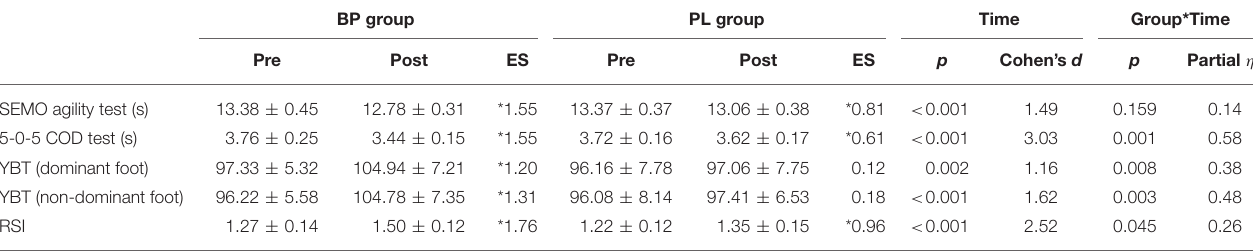
TABLE 3 | Descriptive statistics of agility test results for BP group and PL group before and after the 6-week training intervention. BP group PL group Time Group*Time Pre Post ES Pre